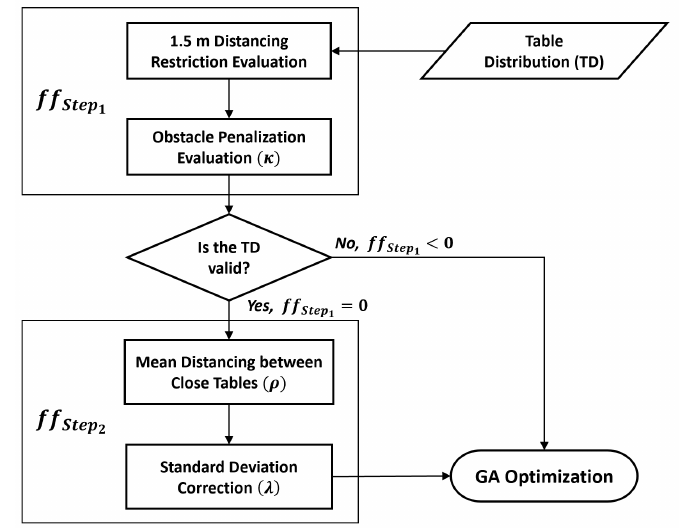
Figure 4. Flux diagram of the GA fitness evaluation proposed for the